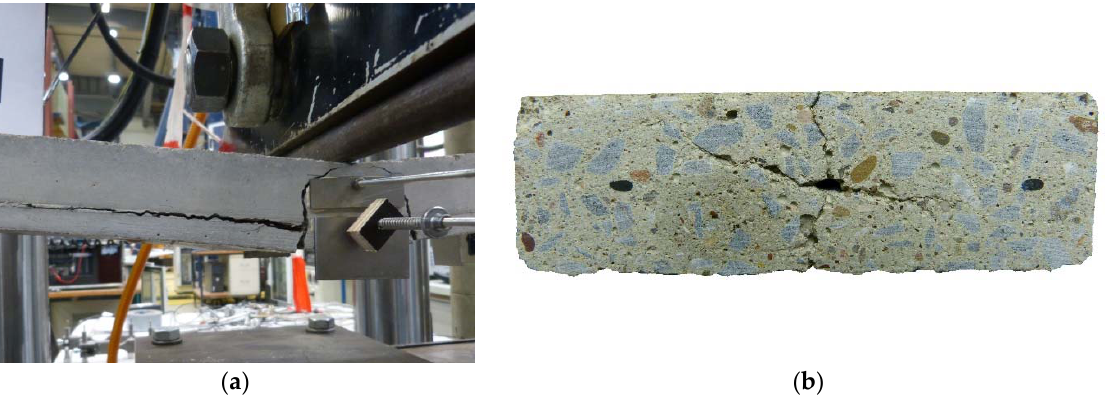
Figure 1. ( a ) Splitting failure of a TRC component tested in a bending tensile test; ( b ) cracking parallel and orthogonal to the textile layer in a cross section of an anchorage length test specimen (photos: Beßling).